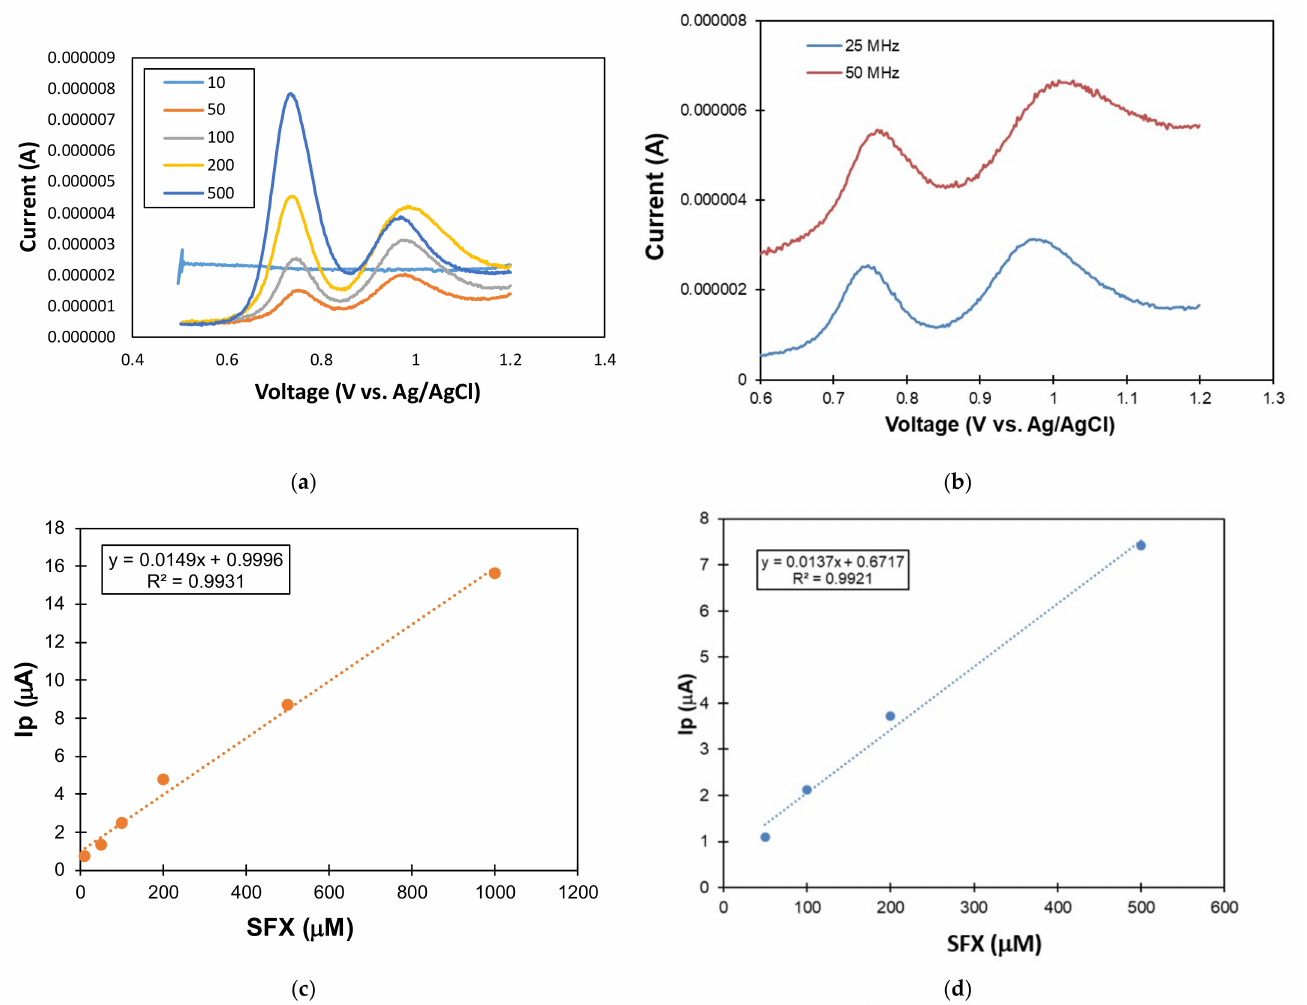
Figure 6. ( a ) Square wave voltammograms of SFX at 25 MHz at different concentrations (10–500 µ M), ( b ) Effect of the frequency on the voltammogram of 100 µ M SFX. Calibration curves of SFX at: ( c ) 50 MHz and ( d ) at 25 MHz. Experimental conditions: working electrode: GCE (3 mm diameter), counter electrode: Pt wire, reference electrode: Ag/AgCl (3 M KCl), electrolyte: 0.05 M phosphate buffer (pH = 7.0), temperature: 25 ◦ C, stagnant